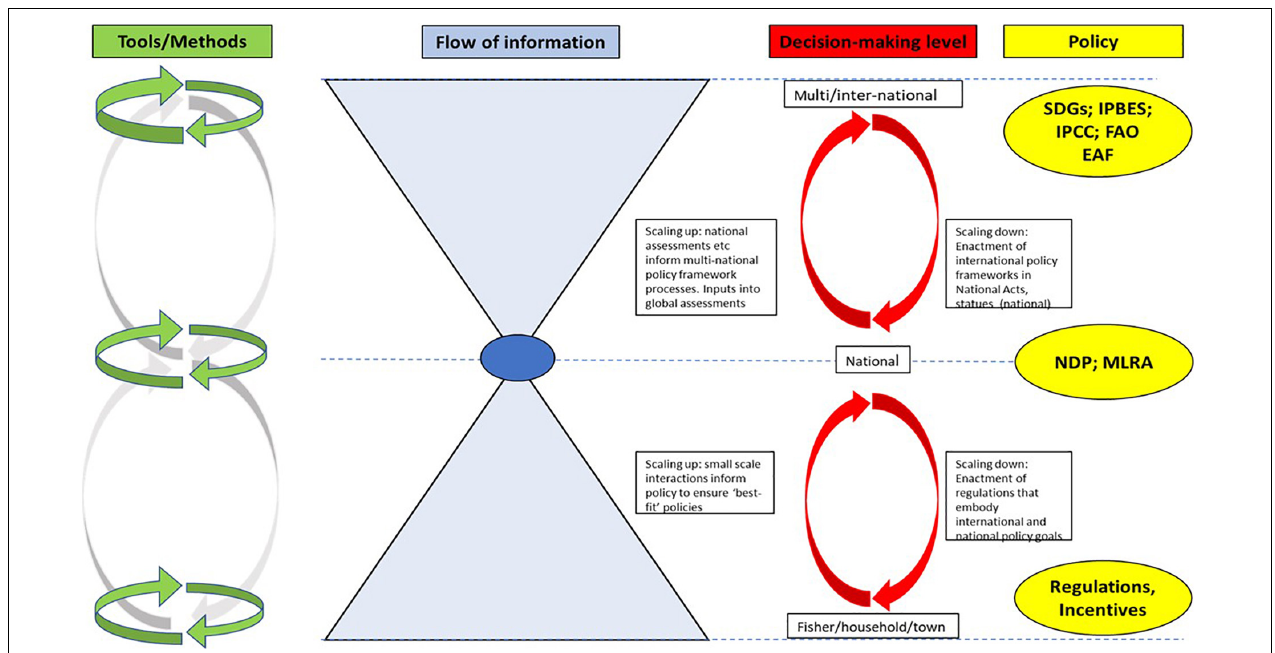
FIGURE 8 | Schematic representation of the potential pathways for scaling within the South African decision-making context. International policy positions and international undertakings are enacted in national policy and legislation. For effective EAF management, actions at the small-scale must inform legislation at the national level and will ultimately shape and inform inputs made to multi-national and international evaluations and policy positions (directly or indirectly). There is thus a need for simultaneous ‘top-down’ and ‘bottom-up’ governance processes – these are not linear, but rather iterative and take place within a decision-making level and between various decision-making levels. By making use of multi-stakeholder approaches such as this overarching scenario-based approach, it becomes possible to facilitate these iterative and interactive processes, there by facilitating better flow of information across scales. Scenario processes and the use of structured decision-making tools will be more effective if used in a governance approach which considers and integrates processes at various scales.